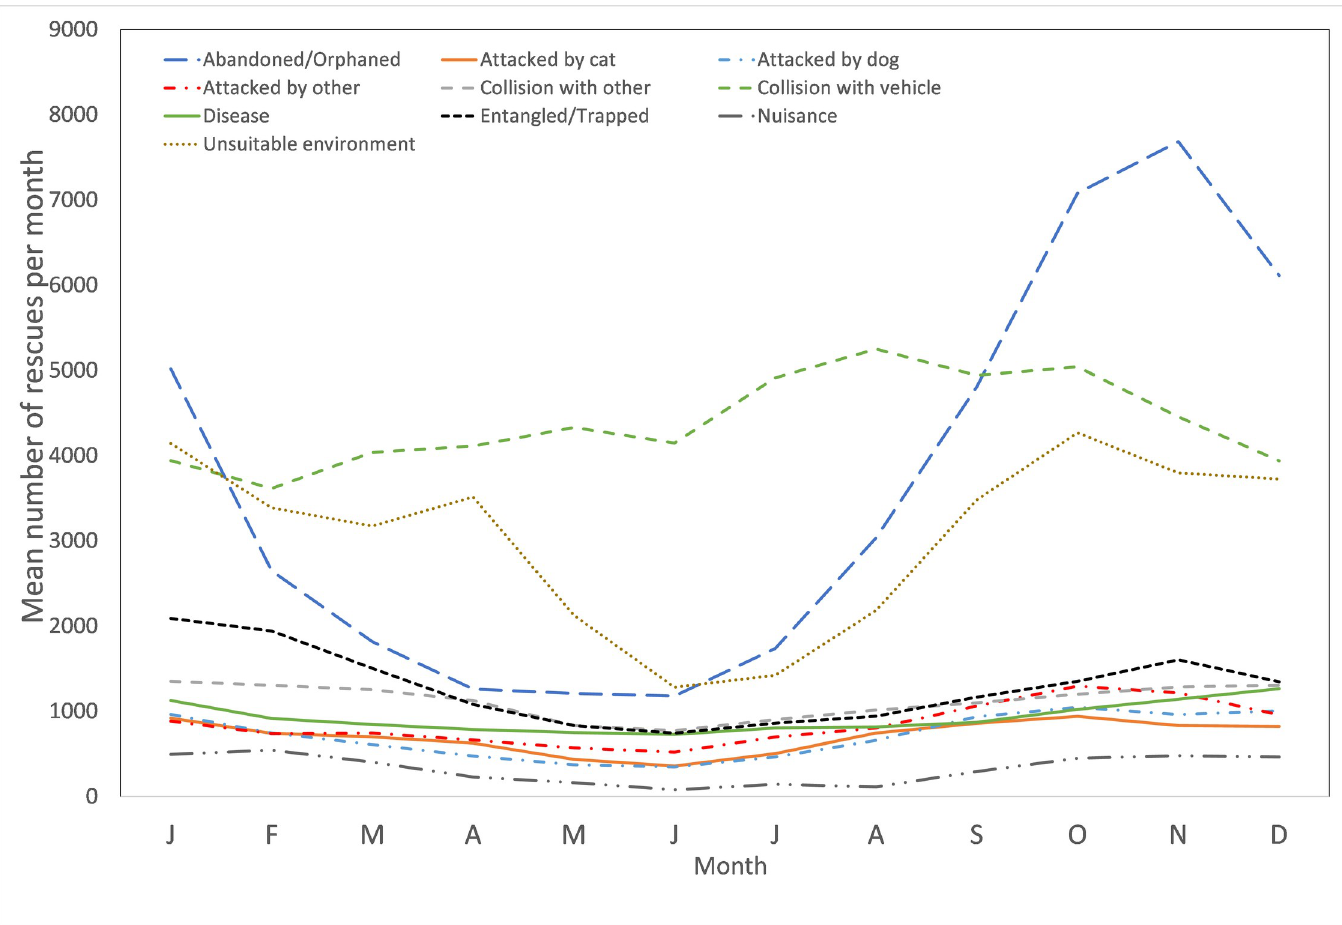
Fig 7. Mean number of rescues per month attributable to each of the top 8 pooled causes for rescue.